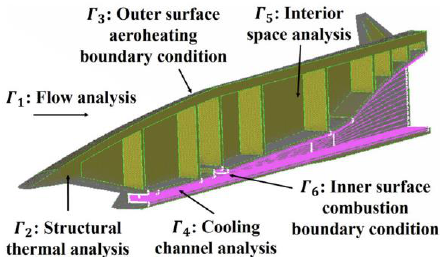
Figure 4. Regimes considered for thermal analysis of X-51A-like aircraft [10]. (The purple marking region in the figure represents the internal flow region of the engine including the cooling channel).